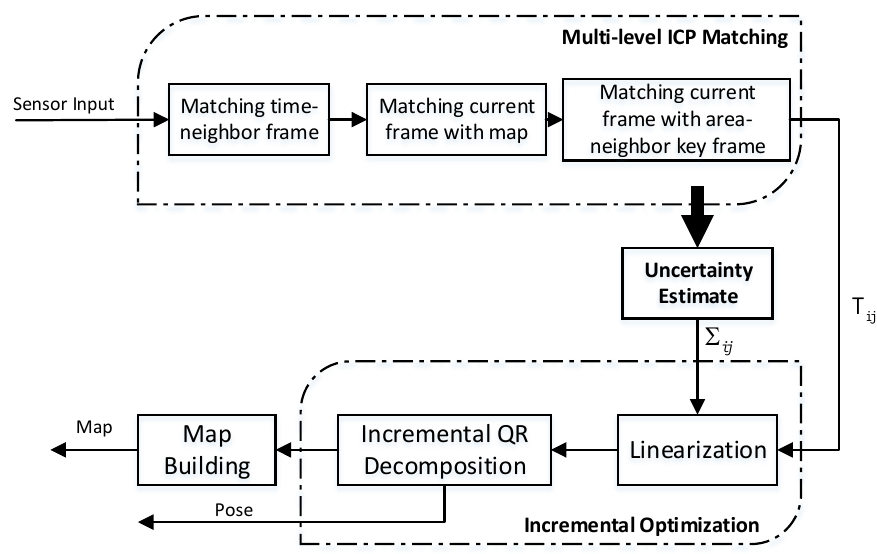
Figure 1. The proposed MIM_SLAM algorithm framework.